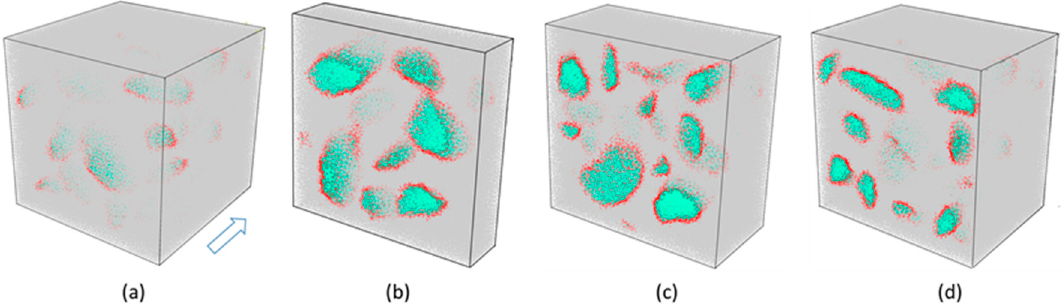
Figure 21. ( a ) A lattice model of numerical mesostructure concrete by the dot matrix method (DMM), ( b ) , ( c ), and ( d ) represents slices obtained from ( a ), respectively.